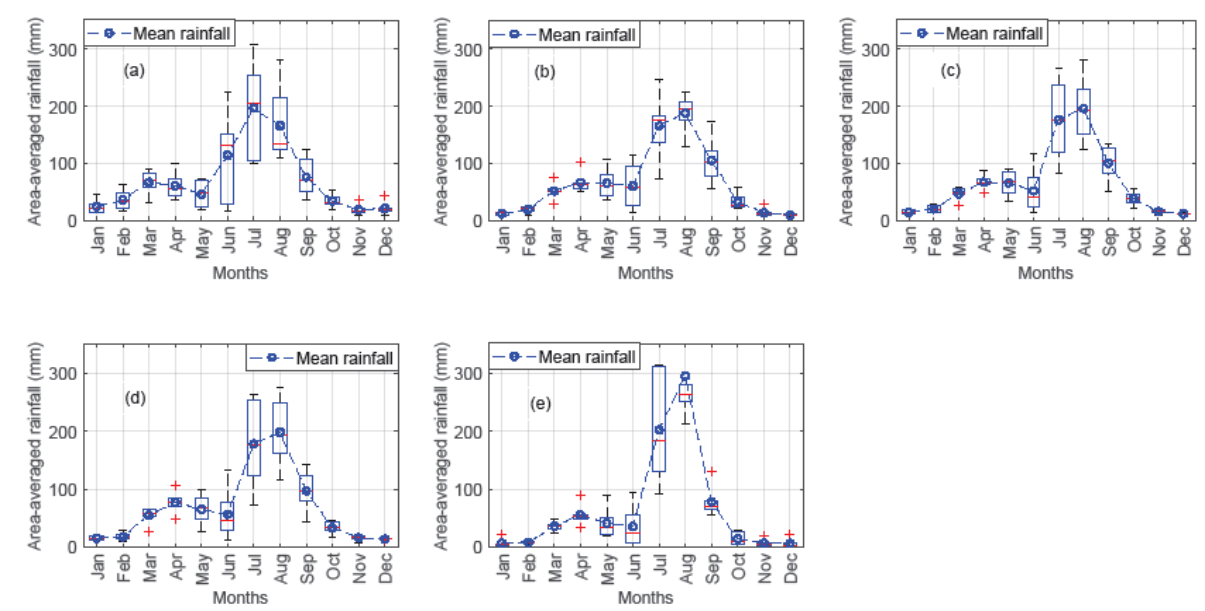
Figure 5. Monthly area-averaged rainfall across the ARB: ( a ) observed rainfall, ( b ) PERSIANN-CDR, ( c ) TRMM 3B43v7, ( d ) IMERG, ( e ) GSMap_NRT. The red plus signs (+) are the outliers of monthly areal average rainfall in sub-basins. Table 3. Categorical error matrix of the ARB. Categorical Error